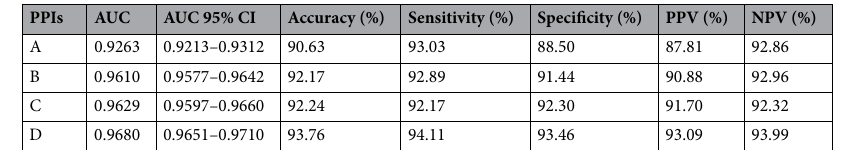
Table 6. Sensitivity, specificity, positive predictive value, negative predictive value, and accuracy between (A) original model, (B) original model with rbs kernel adjustment, (C) model B with three additional features, and (D) features in model C with a random forests